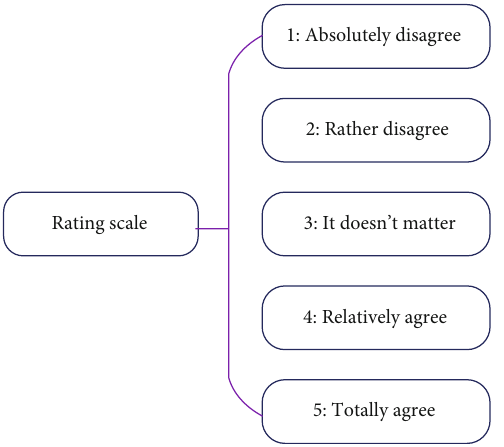
Figure 4: The framework of the research ideas.